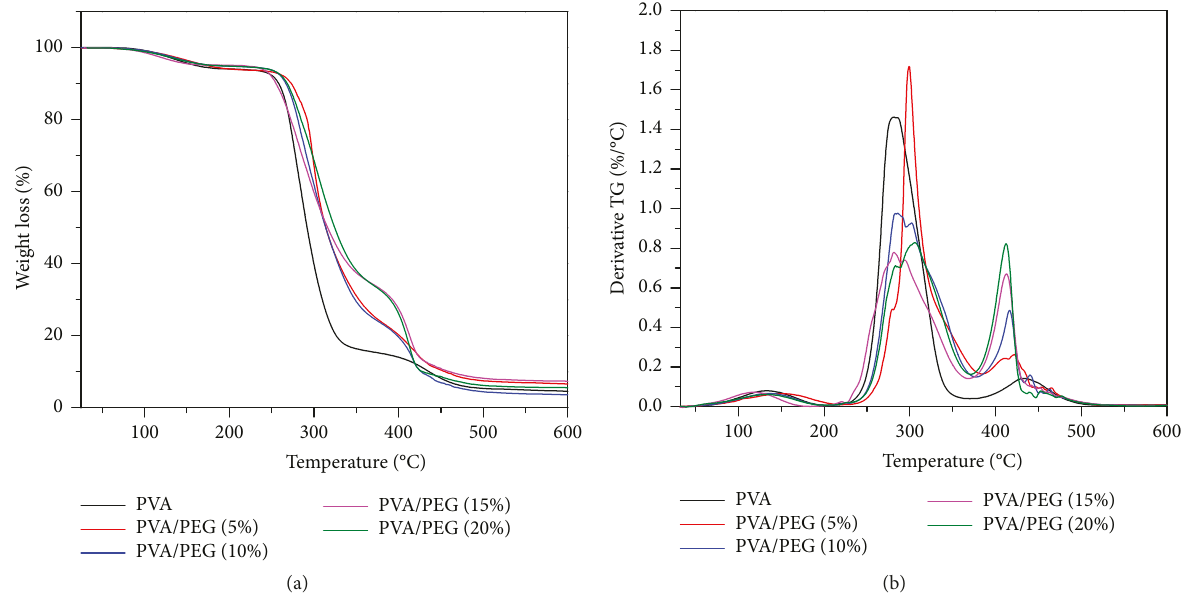
Figure 3: Thermograms for PVA and its blends at di ff erent PEG loadings: (a) TGA and (b) DTG. Table 3: The maximum weight loss rates of PVA and its blends at Table 4: Mechanical properties of PVA and the blends at di ff erent di ff erent PEG loadings. PEG loadings.